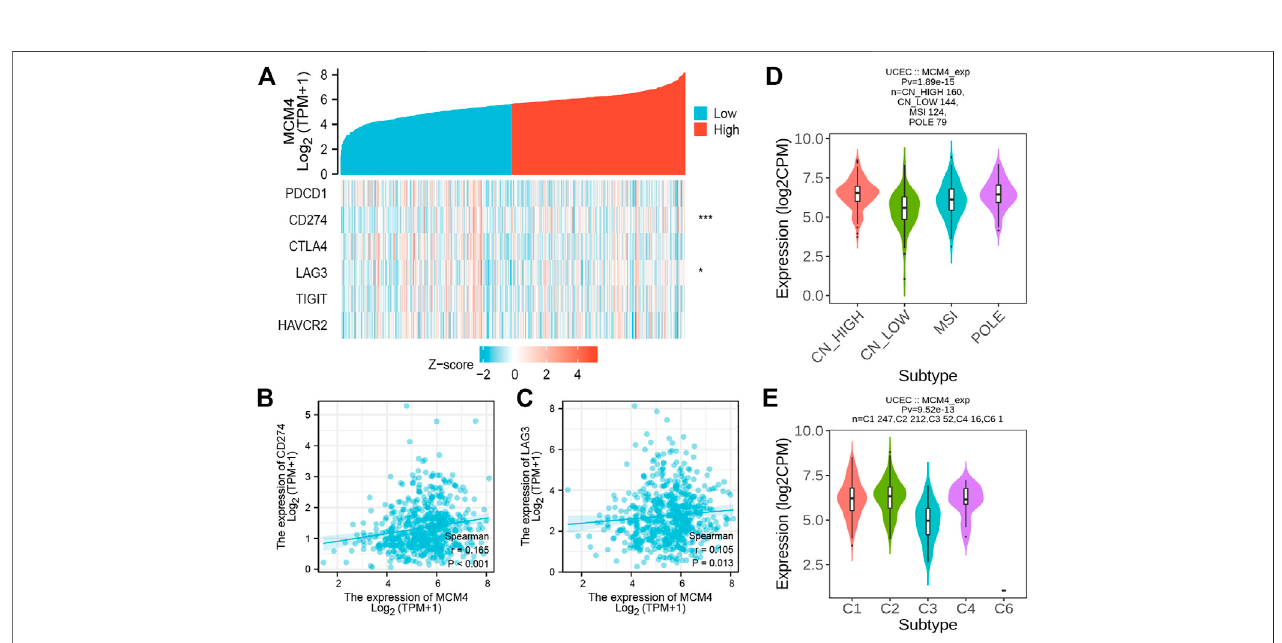
FIGURE5| TherelationshipbetweentheMCM4geneandimmunecheckpoints,molecularsubtypes,andimmunesubtypes. (A) Heatmapofimmunecheckpoints based on MCM4 expression. *: p -value < 0.05; **: p -value < 0.01; ***: p -value < 0.001; (B) MCM4 expression was signi fi cantly and positively correlated with CD274 expression (R = 0.165, p < 0.001); (C) MCM4 expression was signi fi cantly and positively correlated with LAG3 expression (R = 0.105, p = 0.013); (D) Correlations between MCM4 expression and molecular subtypes; (E) Correlations between MCM4 expression and immune subtypes.